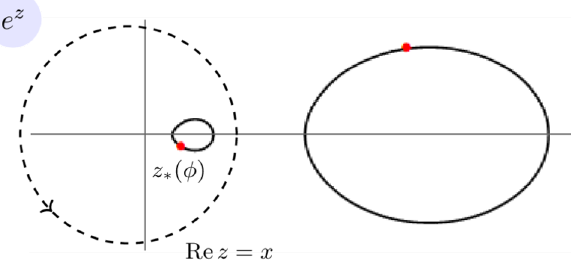
Figure 4 . Slice of the curve by y = const section, plotted in e z coordinate, shown by ovals. C P The y is such that the y = const line crosses a hole of amoeba. Red dots are points with the same φ . Dashed circle is dz integration contour in (3.28), which has to be contracted to